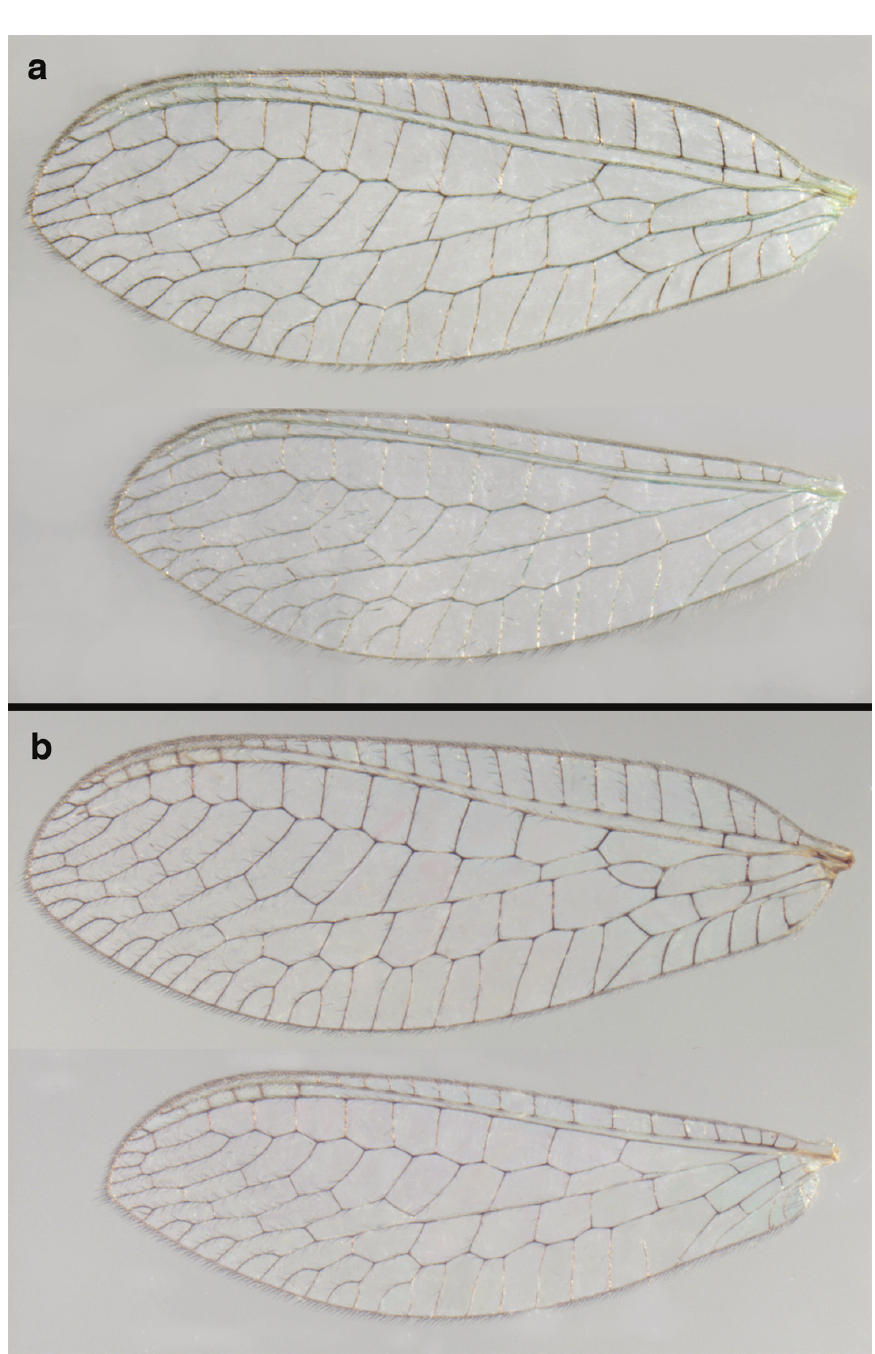
Figure 127. Ungla confraterna (Banks): Wings, showing variation, ( a ) longitudinal veins mostly green ( b ) longitudinal veins mostly brown (Argentina; a La Rioja, male, USNM; b Mendoza, female,